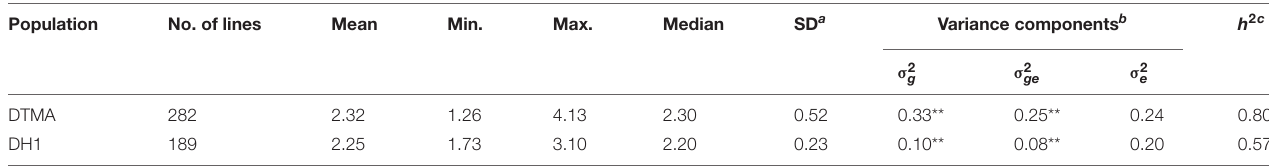
TABLE 1 | Descriptive statistics, variance components, and broad-sense heritability ( H 2 ) response to common rust in the Drought Tolerant Maize for Africa (DTMA) panel and the bi-parental doubled haploid (DH1) population. Population No. of lines Mean